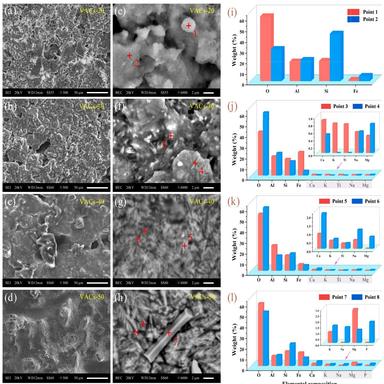
Surface microtopography of VACs specimens with different WTPS additions: (a-d) Low magnification SEM micrograph; (e-h) Magnified SEM micrograph; (i-l) Composition of elements at various positions in (e-h).